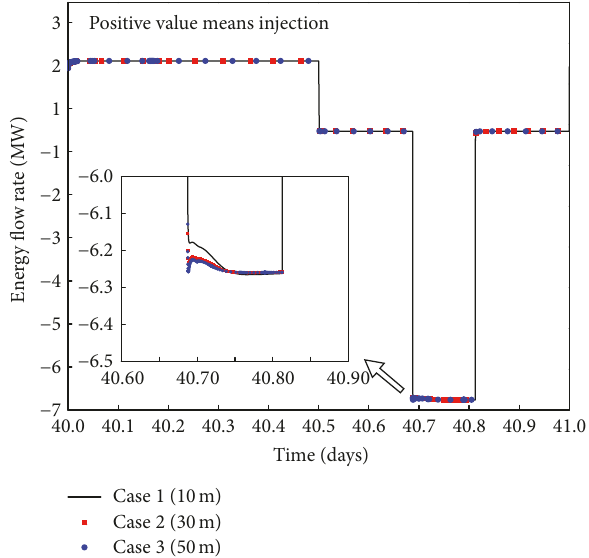
Figure 9: Changes in the wellhead temperature with time among the three energy storage scales of the CAESA